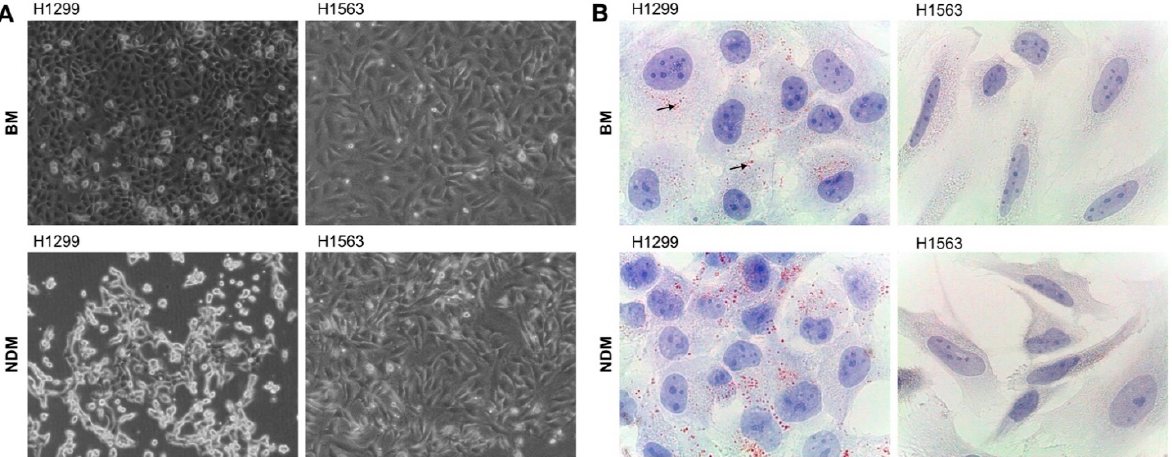
Figure 2. Morphology, and lipid droplet (LD) analysis of H1299 and H1563 cells cultured in NDM vs. BM: ( A ) Cell morphology and adhesion to the plate after 18 h incubation in BM (top images) or NDM (bottom images). Images were taken with a Leica DM IL LED microscope (Leica) equipped with a FLEXACAM C1 camera (Leica) at 100-fold magnification. ( B ) Cells were stained for lipid droplets with Oil red O and for nuclear components with hematoxylin after culture for 18 h in BM (top) or in NDM (bottom). Arrows indicate lipid droplets. Images were taken at 1000-fold magnification using 100× oil immersion objective (Leica). One representative experiment out of four independent experiments is shown. BM, basal medium; NDM, neutrophil degranulation medium.